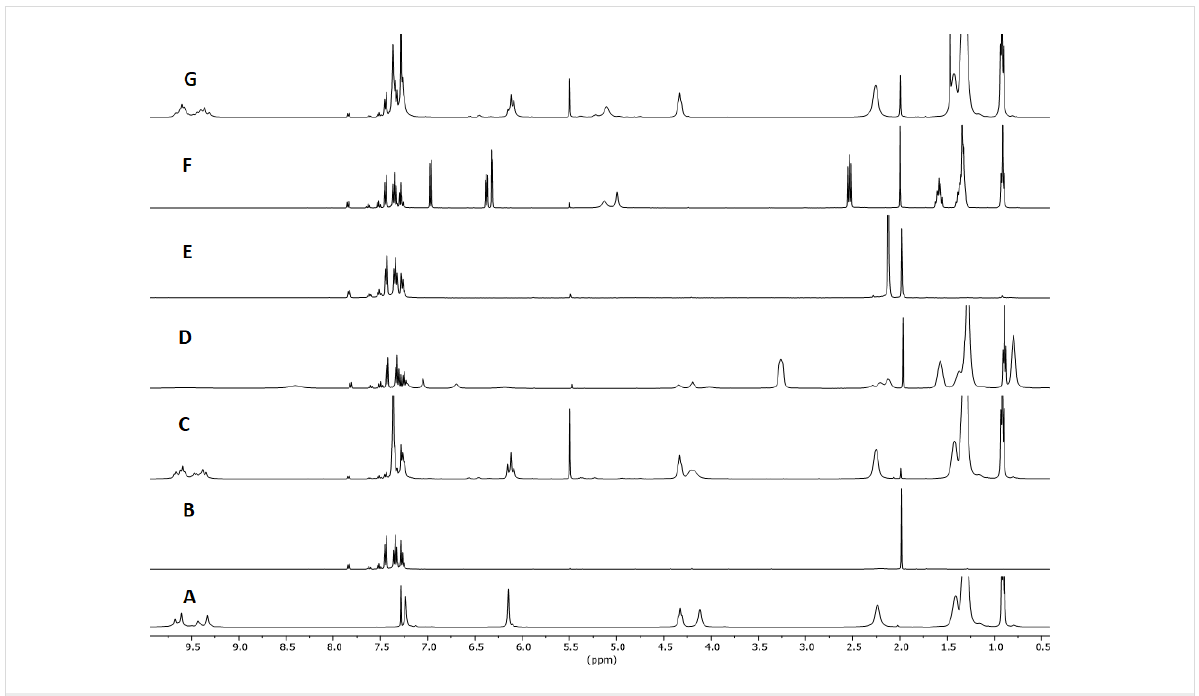
Figure 2: 1 H NMR spectra in water-saturated CDCl 3 except for G. A: [ 1 6 ] (7.5 mM); B: 1,1-diphenylethanol; C: 1,1-diphenylethanol (75 mM), [ 1 6 ] (7.5 mM); D: 1,1-diphenylethanol (75 mM), [ 1 6 ] (7.5 mM), Bu 4 NBr ( 3 , 78 mM); E: 1,1-diphenylethanol (75 mM), acetic acid (29 mM); F: 1,1- diphenylethanol (75 mM), n -hexylresorcinol ( 2 , 30 mM); G: 1,1-diphenylethanol (75 mM), [ 1 6 ·8H 2 O] (7.5 mM). Spectra recorded after 3 h at 60 °C, while A and B were recorder right after sample preparation.